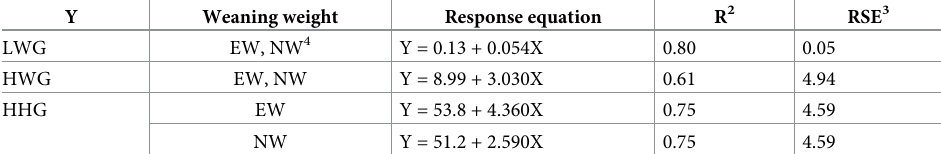
Table 1. The effect of supplement intake (X) 1 and weaning weight on liveweight gain (LWG), hip height gain (HHG) and hip width gain (HWG) of early (EW) and normally (NW) weaned 2 crossbred Brahman